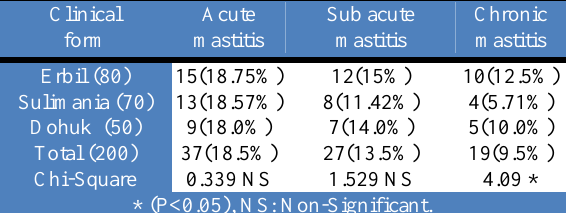
Table, 4: Shows the clinical forms of mastitis in goats in the three governorates.